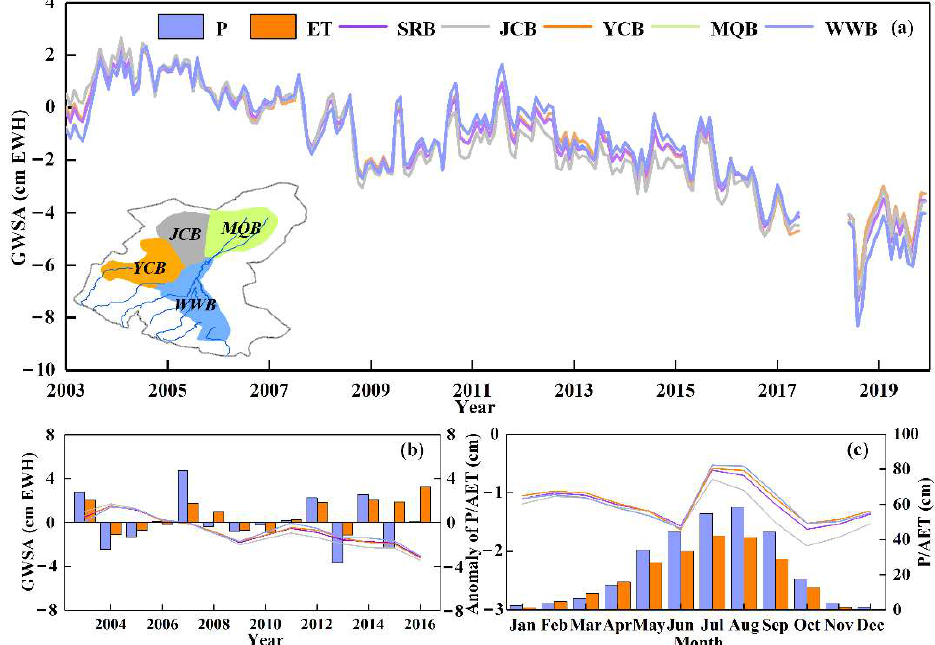
Figure 10. Changes of groundwater storage anomalies in subregions from 2003 to 2019: ( a ) represents the monthly GWSA changes of different subregions, ( b ) represents the annual mean variation of the groundwater storage, precipitation (P) and actual evapotranspiration (AET) anomalies, ( c ) represents the interannual seasonal variations of the GWSA, precipitation and actual evapotranspiration.